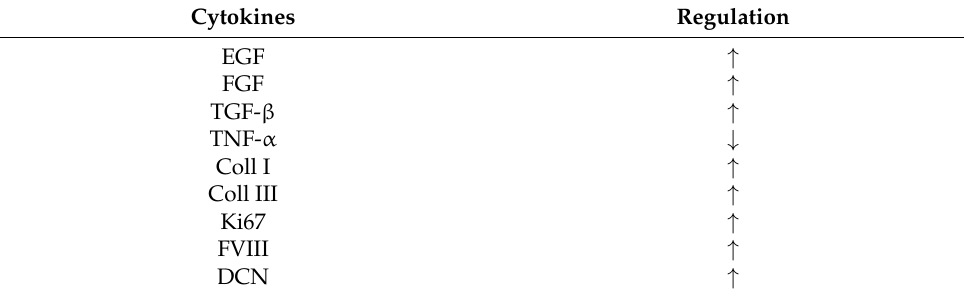
Table 1. Overview of cytokines influenced by PBM and